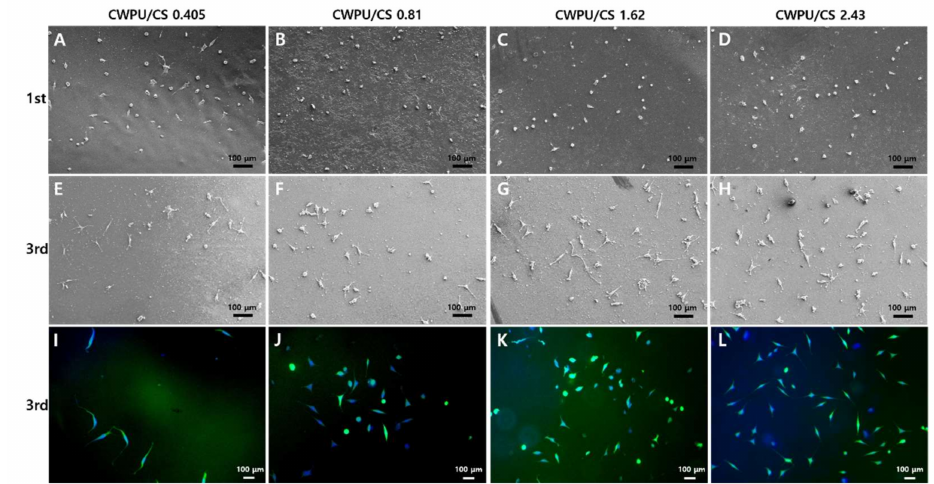
Figure 7. Scanning electron microscopy images of 1st ( A – D ) and 3rd ( E – H ) days growth, and ( I – L ) Fluorescence microscopic images of CellTracker TM Green CMFDA (green) and DAPI (blue) staining for CCD-986K skin fibroblasts on CWPU/CS nanocomposites according to various CS contents (scale 100 µ